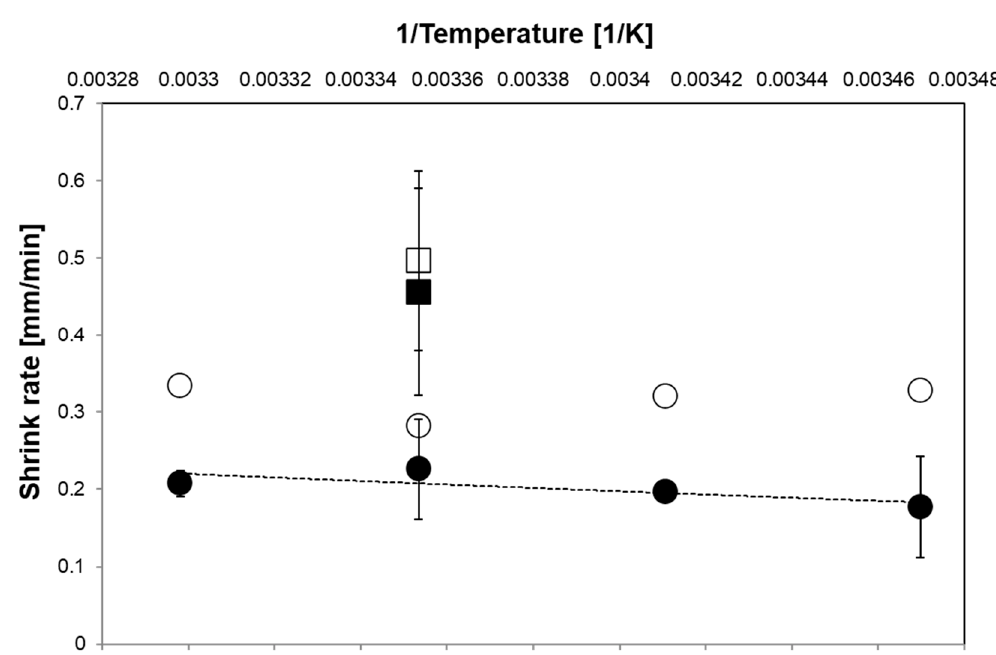
Figure 5. Temperature dependence of dissolution rates. Solid marks are experimental data, and open marks are model predictions. The error bars represent the standard deviations of the replicates. Square marks correspond to dissolution in pure water, and circles, to the seawater case. The dotted line is a fitted curve for the experimental data for seawater that is calculated using Equation (3).